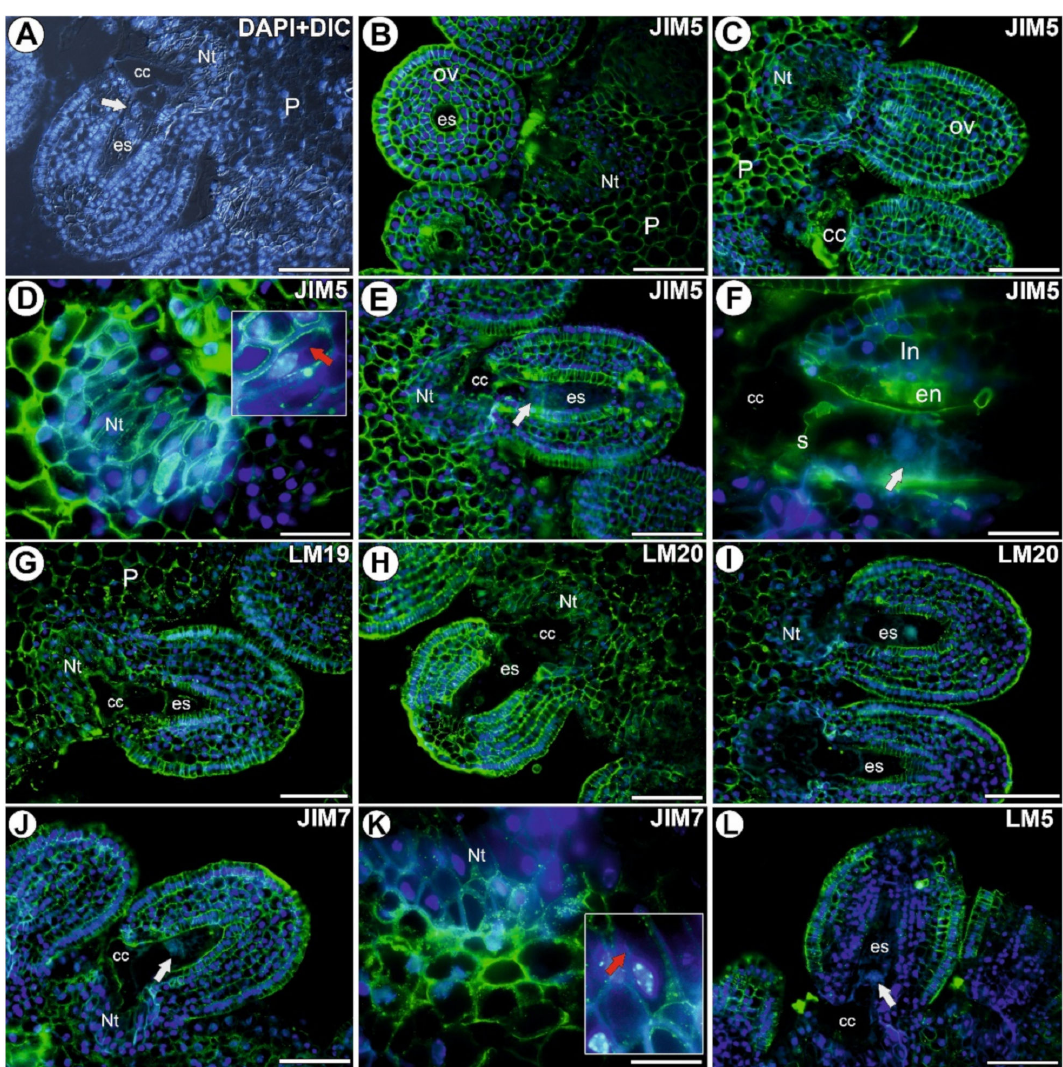
Figure 1. Histology and detection of the homogalacturonan in an ovule of Utricularia nelumbifolia before pollination (Antibodies–green fluorescence). ( A ) Section through the ovule and placenta that was stained with DAPI blue fluorescence and with differential interference contrast (DIC) optics. Note the presence of a mature embryo sac (es) with an egg cell (white arrow), hypertrophied part of the central cell (cc), placental nutritive tissue (Nt), placenta (P), bar 50 µ m. ( B , C ) Pectic epitope (labeled with JIM5) in the ovule (ov) and placenta (P); mature embryo sac (es), hypertrophied part of the central cell (cc), bars 50 µ m. ( D ) Pectic epitope (labeled with JIM5) in the placental nutritive tissue (Nt), the framed part shows the nuclei with the chromatubule (red arrow), bar 20 µ m. ( E , F ) Pectic epitope (labeled with JIM5) in the embryo sac (es); hypertrophied part of the central cell (cc), synergid (s), egg cell (white arrow), endothelium (en), integument (In), placental nutritive tissue (Nt), bar 50 µ m and bar 20 µ m. ( G ) Pectic epitope (labeled with LM19)detected; placenta (P); mature embryo sac (es), hypertrophied part of the central cell (cc), bar 50 µ m. ( H , I ) Pectic epitope (labeled with LM20) detected; mature embryo sac (es), hypertrophied part of the central cell (cc), placental nutritive tissue (Nt), bar 50 µ m. ( J ) Pectic epitope (labeled with JIM7) detected; egg cell (white arrow), hypertrophied part of the central cell (cc), placental nutritive tissue (Nt), bar 50 µ m. ( K ) Pectic epitope (labeled with JIM7) in the placental nutritive tissue (Nt), the framed part shows the nuclei with the chromatubule (red arrow), bar 20 µ m. ( L ) Pectic polysaccharides (1-4)- β -D-galactan (labeled with LM5) detected; embryo sac (es), egg cell (white arrow), hypertrophied part of the central cell (cc), bar 50 µ